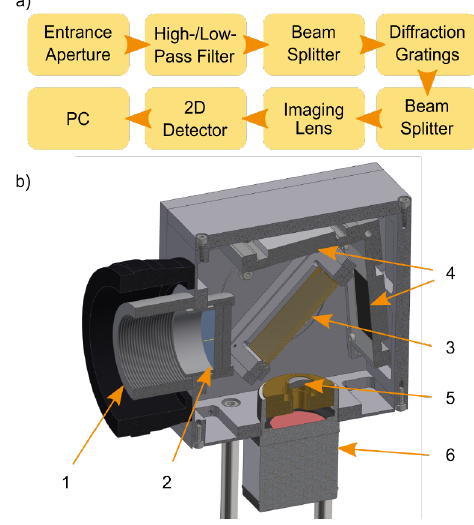
Figure 1: (a) Configuration of the SHS and (b) 3D assem- bly view: entrance aperture (1), filter (2), beam splitter (3), gratings (4), imaging lens (5), and detector (6). A SHS is heterodyning the signal, so the spatial